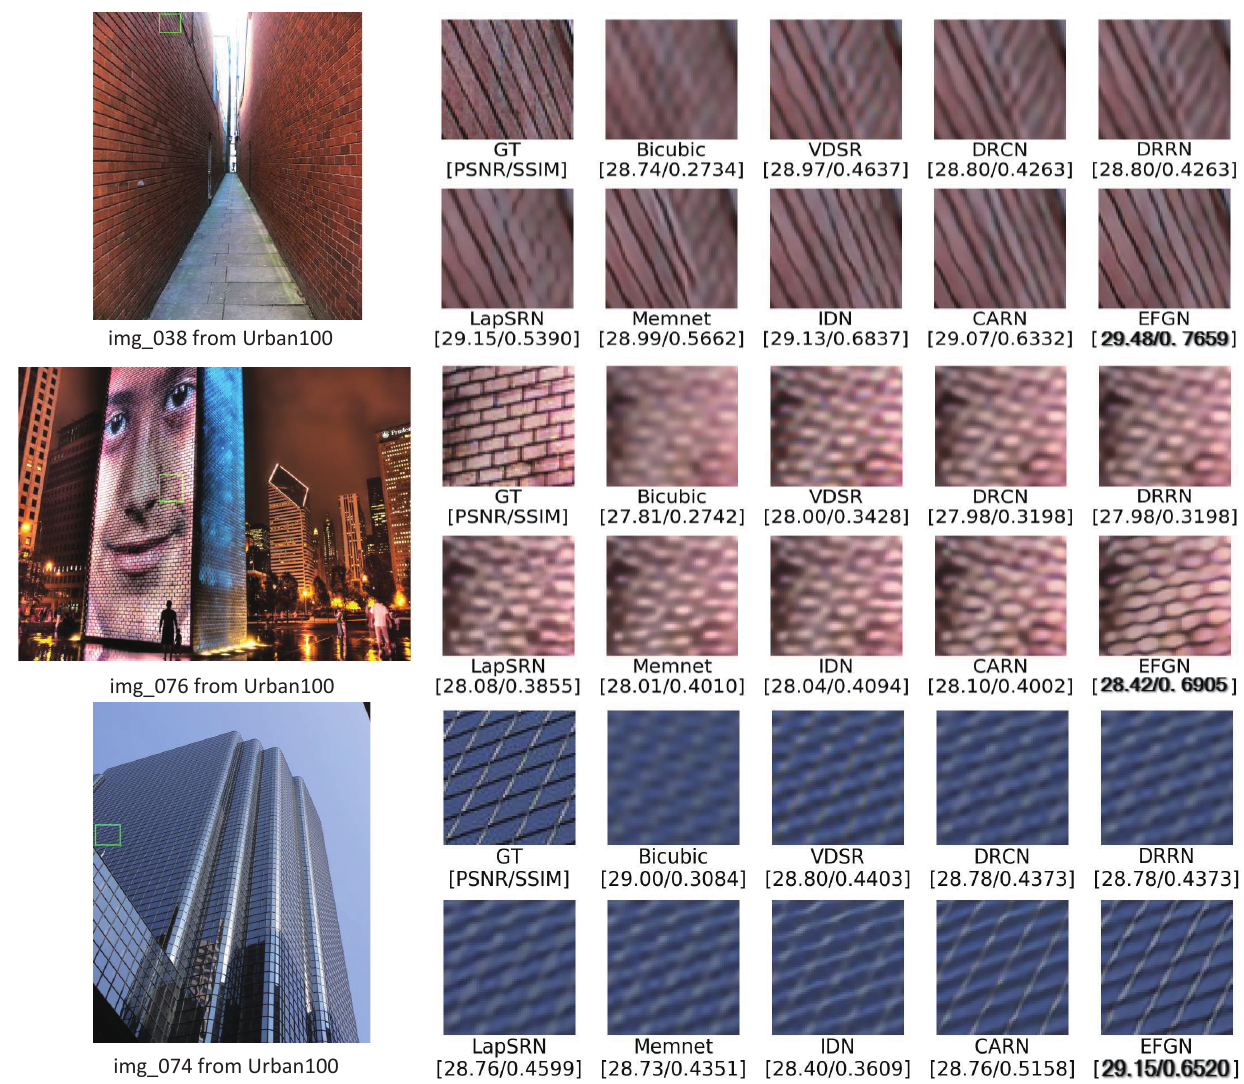
Figure 9. Qualitative comparison of EFGN with other deep learning-based methods on × 4